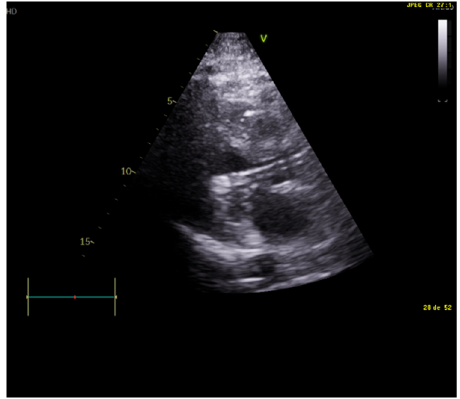
Figure 5. Impella device acoustic noise.